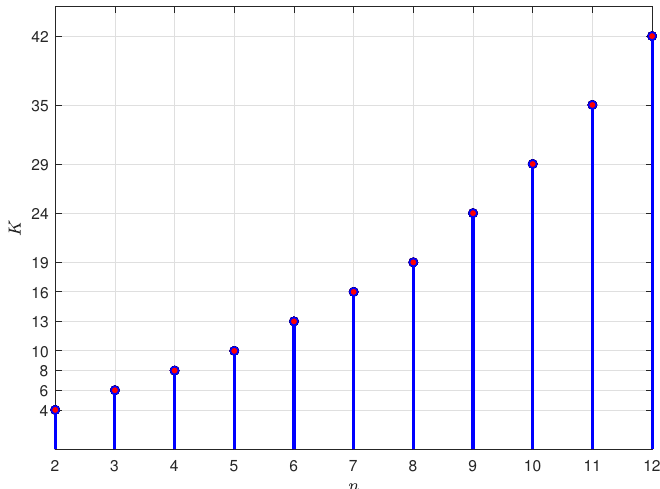
Figure 4. Value of the constant K for dimension varying from 2 to